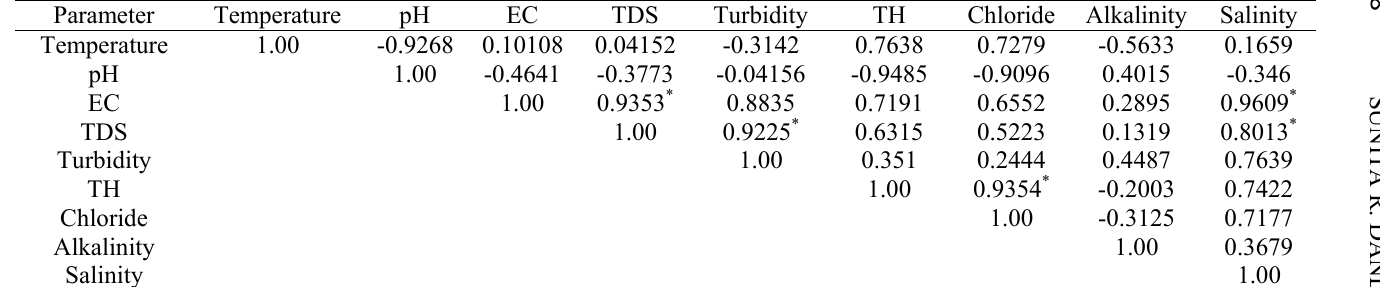
Table 3. Correlation matrix for water quality parameters (Pre-monsoon)